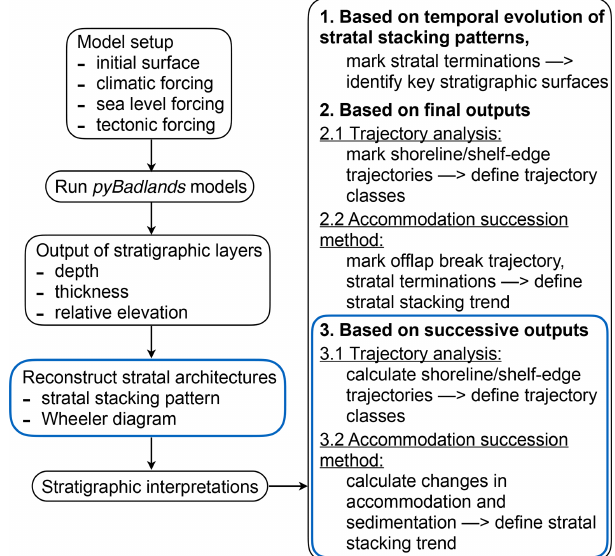
Figure 1. Workflow to build the stratigraphic architecture in pyBad- lands. We present three different ways of stratigraphic interpreta- tion. The new post-processing workflows designed to automatically interpret stratigraphic sequences are shown in the blue